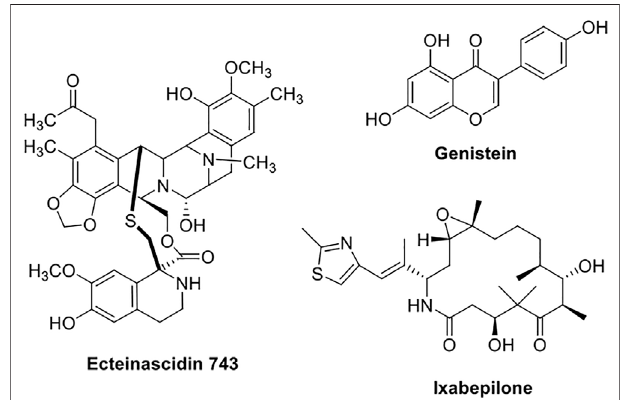
FIGURE 3 | Chemical structures of phytochemicals (Ecteinascidin-743, genistein, and Ixabepilone) used in endometrial cancer in clinical studies.